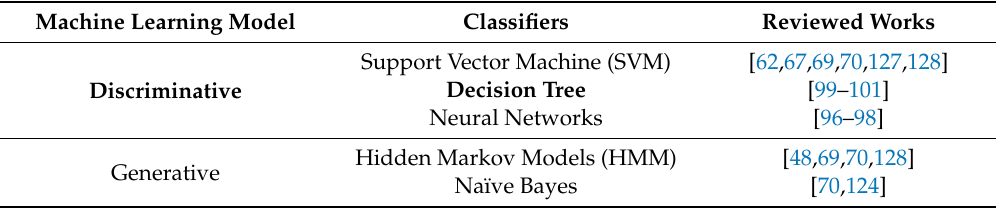
Table 5. List of machine learning classifiers used in the literature for ADL